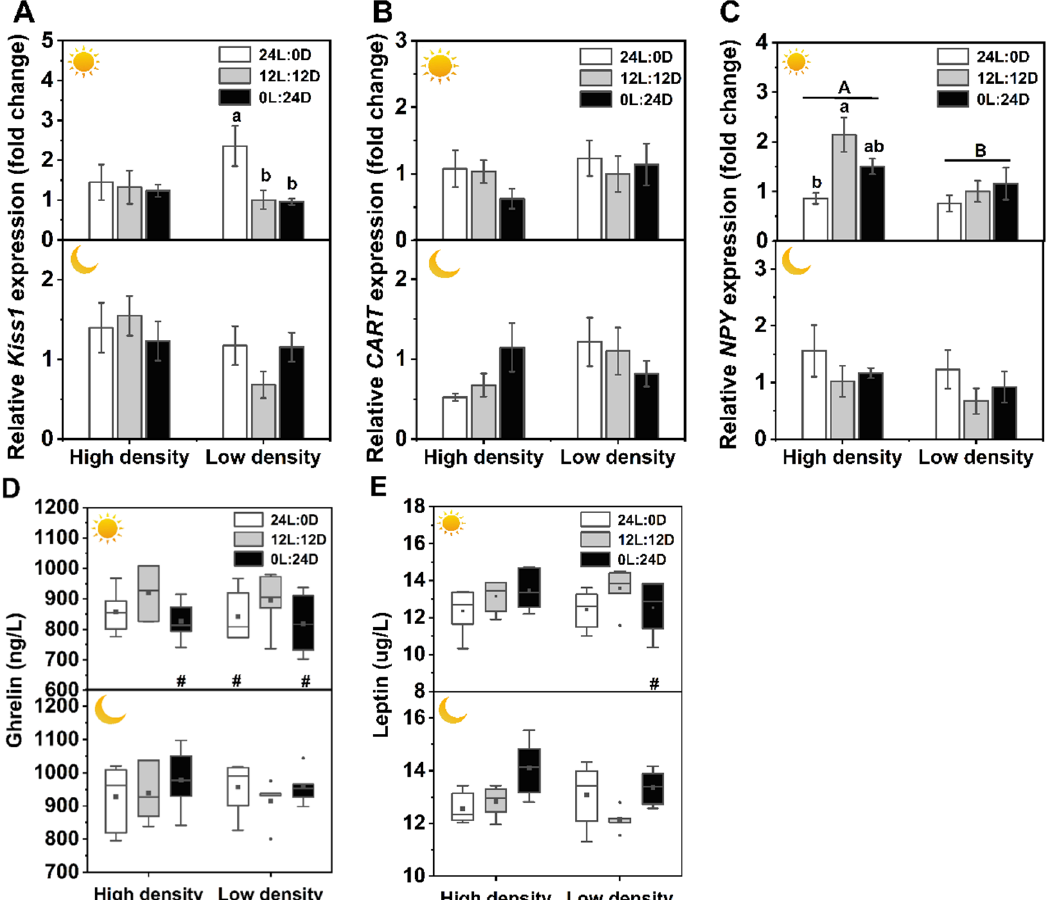
Figure 3. Effects of photoperiod and density on the mRNA expression levels of appetite-related genes in the brain, plasma leptin and ghrelin in Pelodiscus sinensis . Kiss1 ( A ), CART ( B ), NPY ( C ), plasma leptin ( D ), and plasma ghrelin ( E ). and indicate daytime and nighttime, respectively. Data are n = 5 or 6 for all groups. Data are presented as the mean ± S.E. In ( A )–( C ), different lowercase letters denote statistically significant differences among different photoperiods in each density; different capital letters indicate a significant difference between different densities ( p < 0.05). In ( D , E ), the description of the box plots is the same as that shown in Figure 1. # indicate a significant difference between the daytime and nighttime ( p < 0.05).